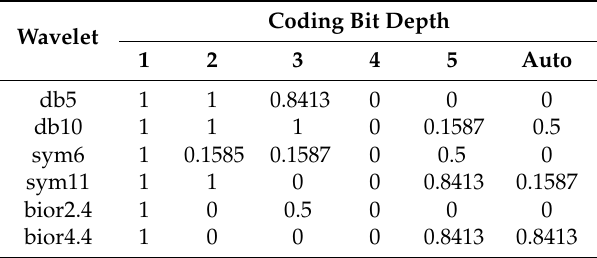
Table 4. T -test value (confidence level p = 0.05) of pairwise comparisons of 100-elements error sets between numerical and textual watermark contents; the interval measured was QRS complex.